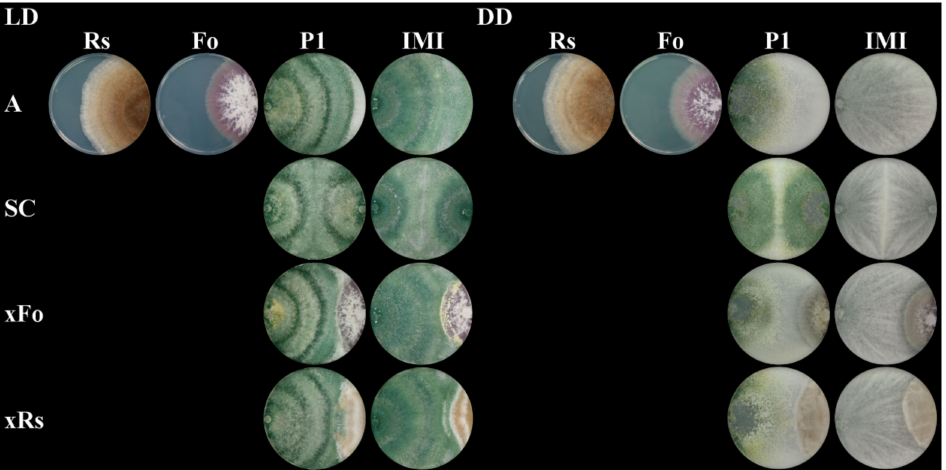
Figure 3. Strain-specific di ff erences in the mycoparasitic behavior against Fusarium oxysporum and Rhizoctonia solani upon incubation under di ff erent light regimes. Plate confrontation assays of the mycoparasites T. atroviride P1 (P1) and T. atroviride IMI 206040 (IMI) against the host fungi F. oxysporum (Fo) and R. solani (Rs). As controls, all strains were grown alone (A). The mycoparasites were as well grown in self confrontation (SC) and in direct confrontation with F. oxysporum (xFo) or R. solani (xRs) on PDA at 25 ◦ C for five days under either light-dark (LD) conditions or complete darkness (DD). A representative image of four biological replicates ( n = 4) is